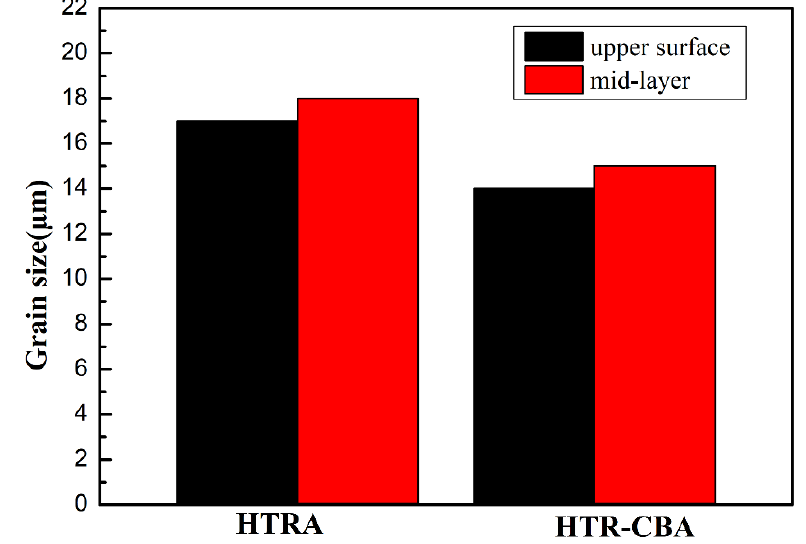
Figure 5. The average grain size of HTRA and HTR-CBA samples.